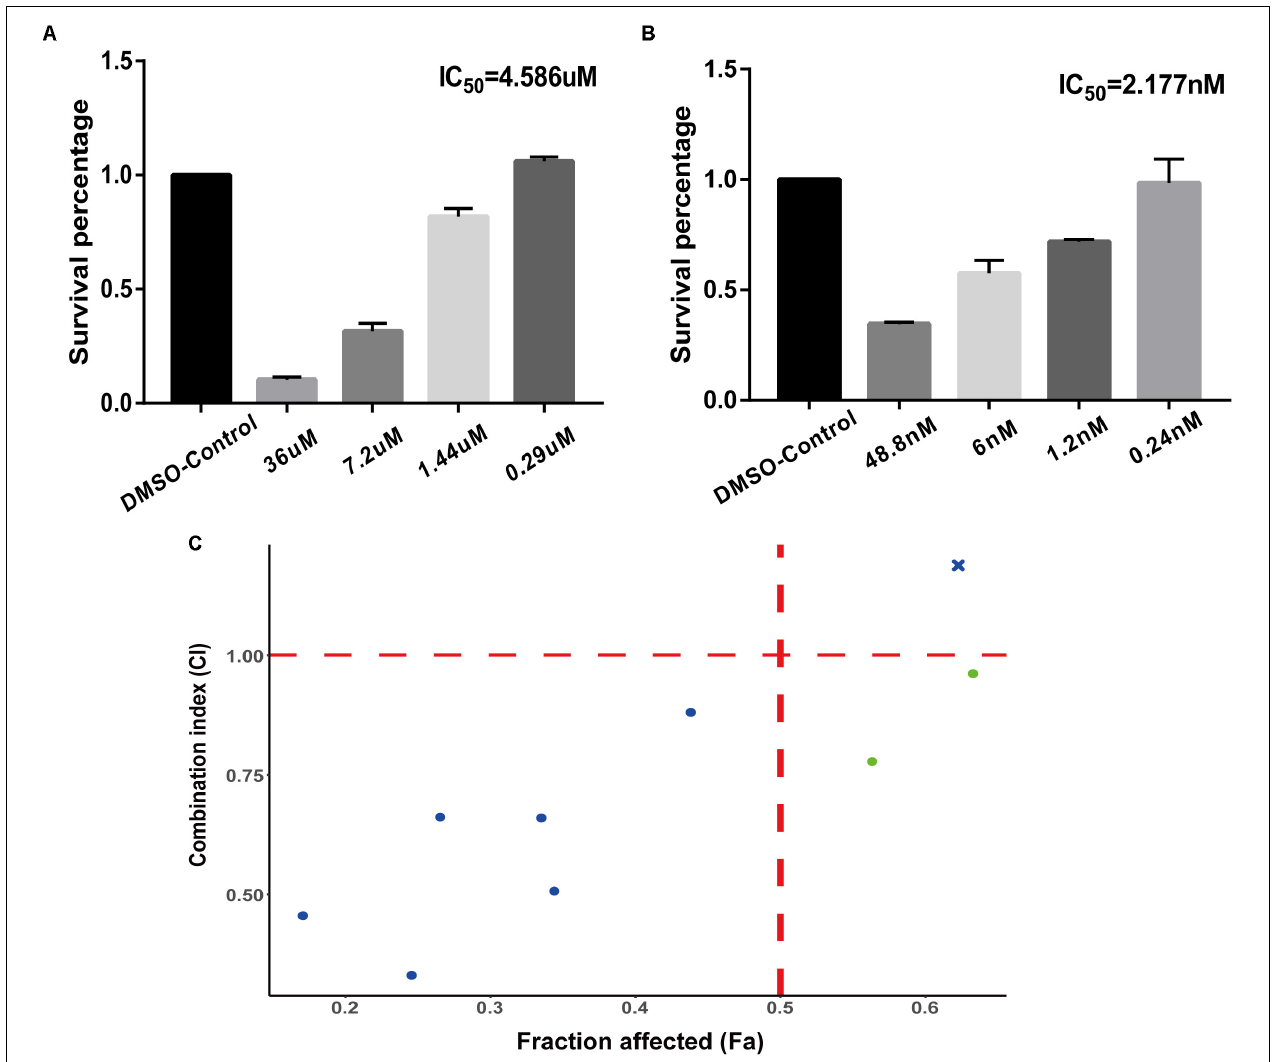
FIGURE 3 | Experiments of drug combinations. (A) IC 50 value of monobenzone against the A375 cell line. (B) IC 50 value of paclitaxel against the A375 cell line. (C) The scatter plot of CI versus fraction affected (Fa).